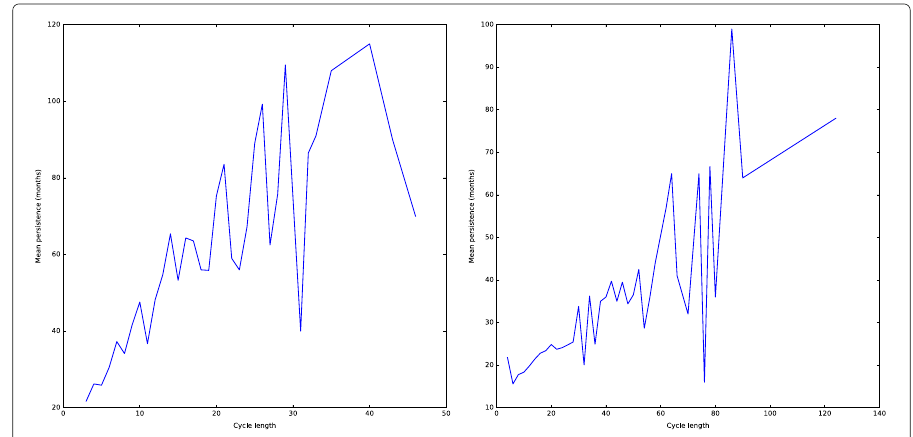
Fig. 10 Longer cycles live longer. The plots report cycle size on the x -axis and cycle mean persistence on the y -axis for H 1 (left) and H 2 (right). In both cases the trend shows that longer cycles are more difficult to break